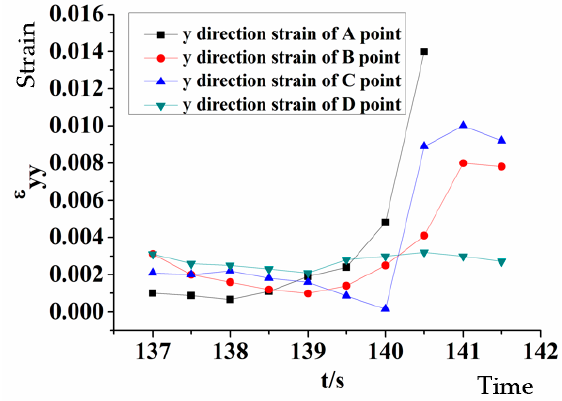
Figure 11. Y-direction strain–time relationship of sandstone (loading rate = 0.1 MPa/s).